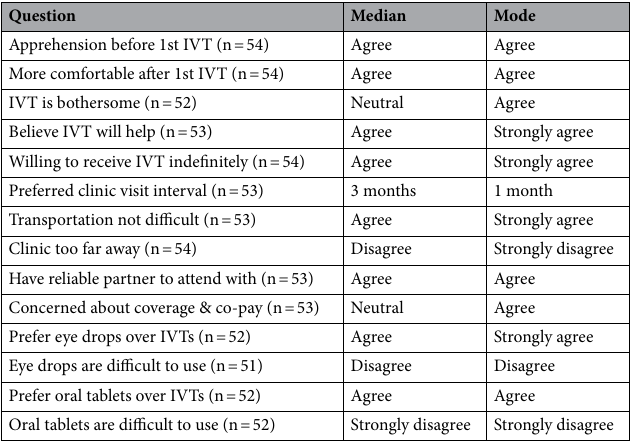
Table 2. Response to Likert-scaled survey questions about intravitreal (IVT) injections, other potential non- compliance factors, and alternative treatment